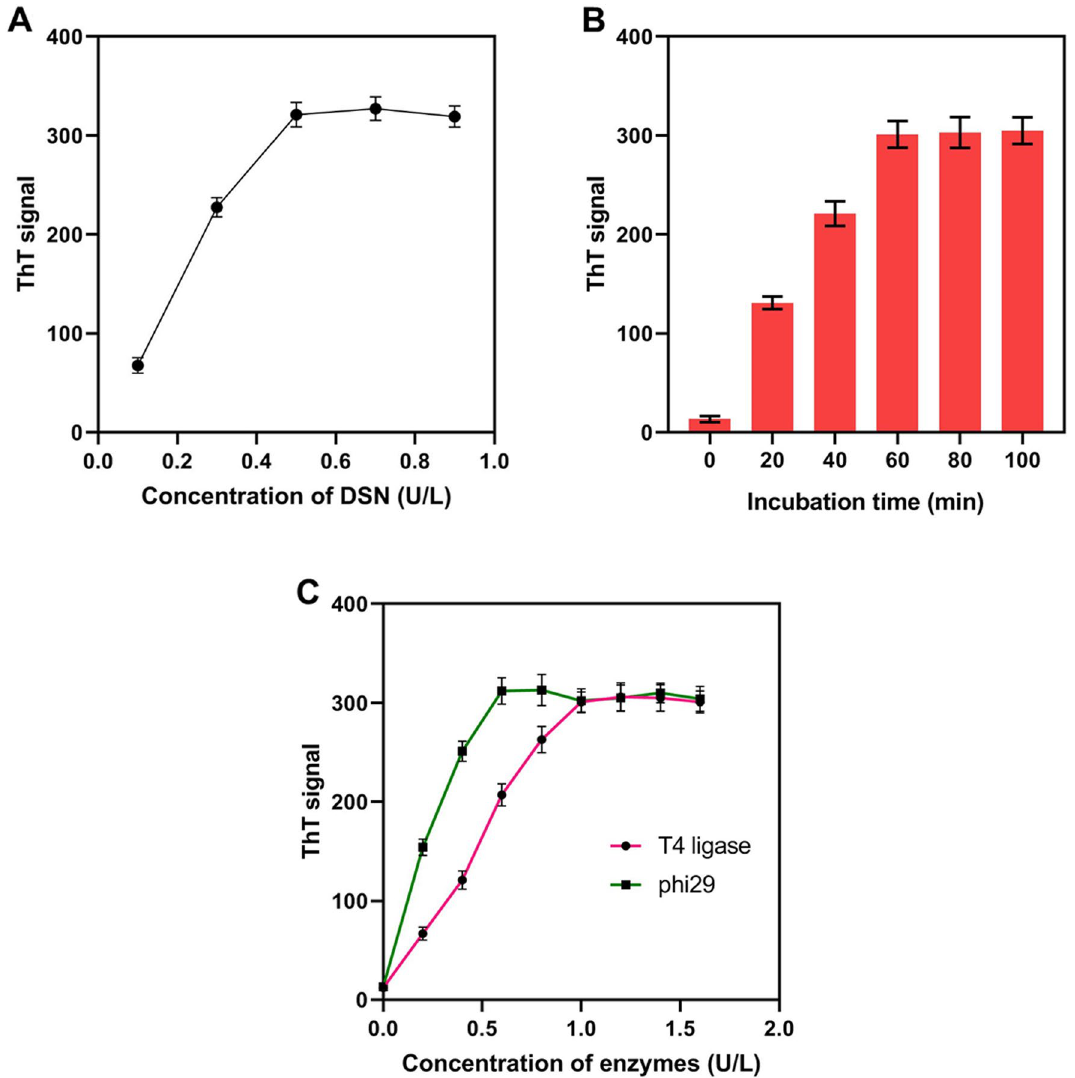
Fig. 3 Optimization of experimental conditions. ThT signal of DiRCA with different concentrations of DSN enzyme ( A ), incubation time ( B ), and concentrations of T4 DNA ligase and phi29 enzyme ( C